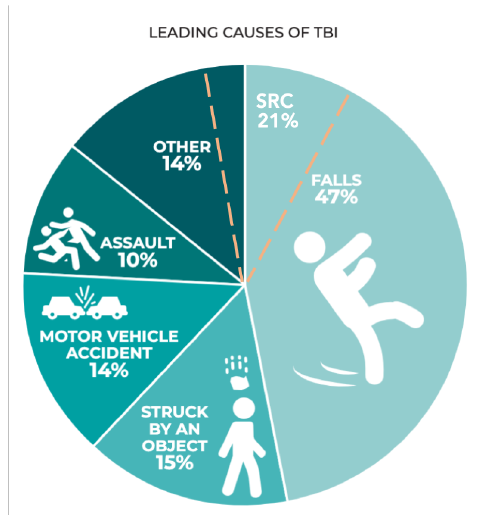
Figure 1. Leading causes of TBI in the 2014 CDC TBI surveil- lance report (published in 2019) based on hospital admissions in the US(Prevention, 2019). Sport-related concussion (SRC) has been added by authors (dashed orange line) based on communi- ty data from Theadom et al. (Theadom et al.,